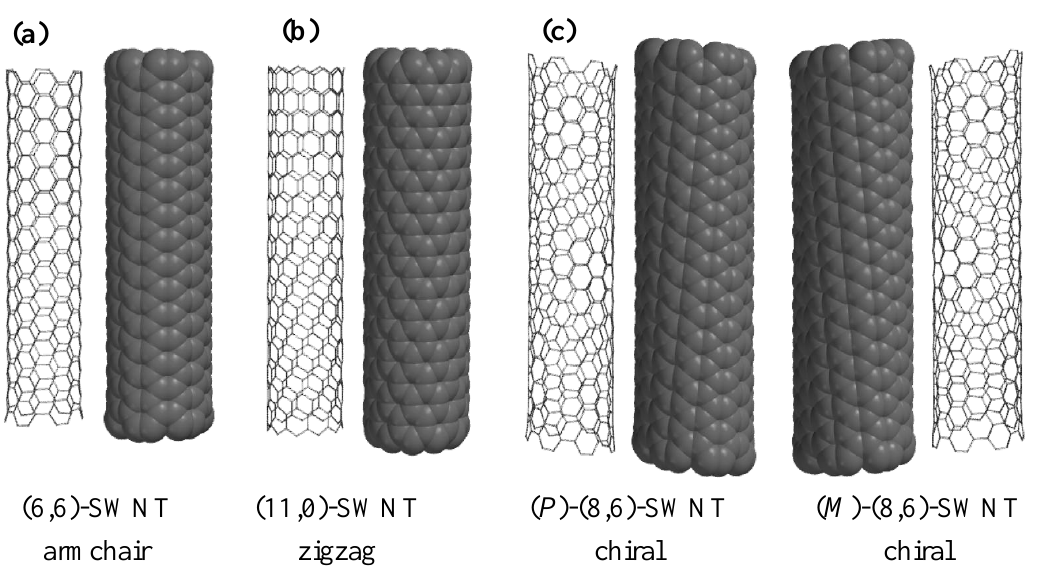
Figure 1. (a) Armchair, (b) zigzag, and (c) chiral SWNTs. P and M describing the handedness of CNTs are defined in Figures 2 and